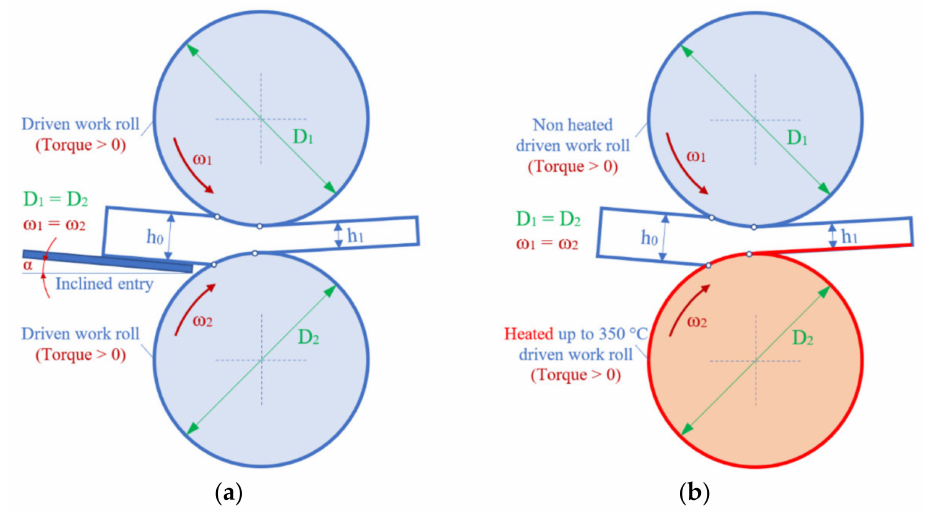
Figure 4. Schematic illustration of asymmetric rolling processes: ( a ) Rolling with inclined entry of the sheet into the roll gap; ( b ) rolling with temperature differences.